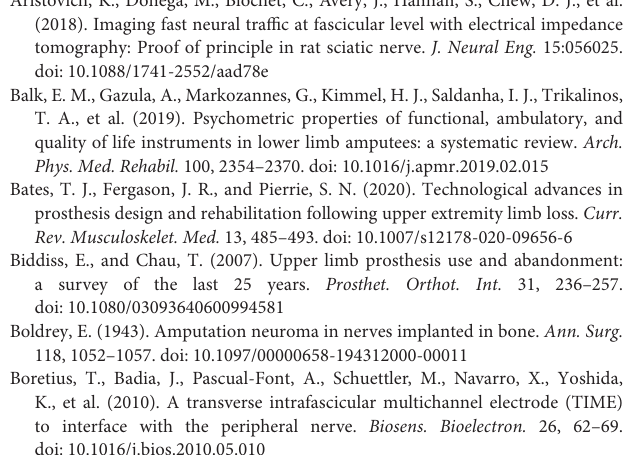
Pain Mechanical